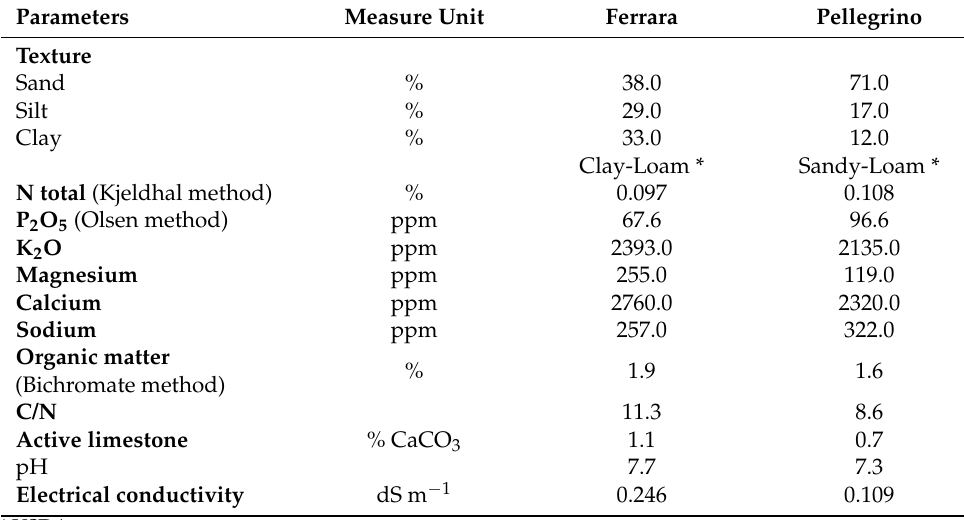
Table 5. Chemical and physical properties of